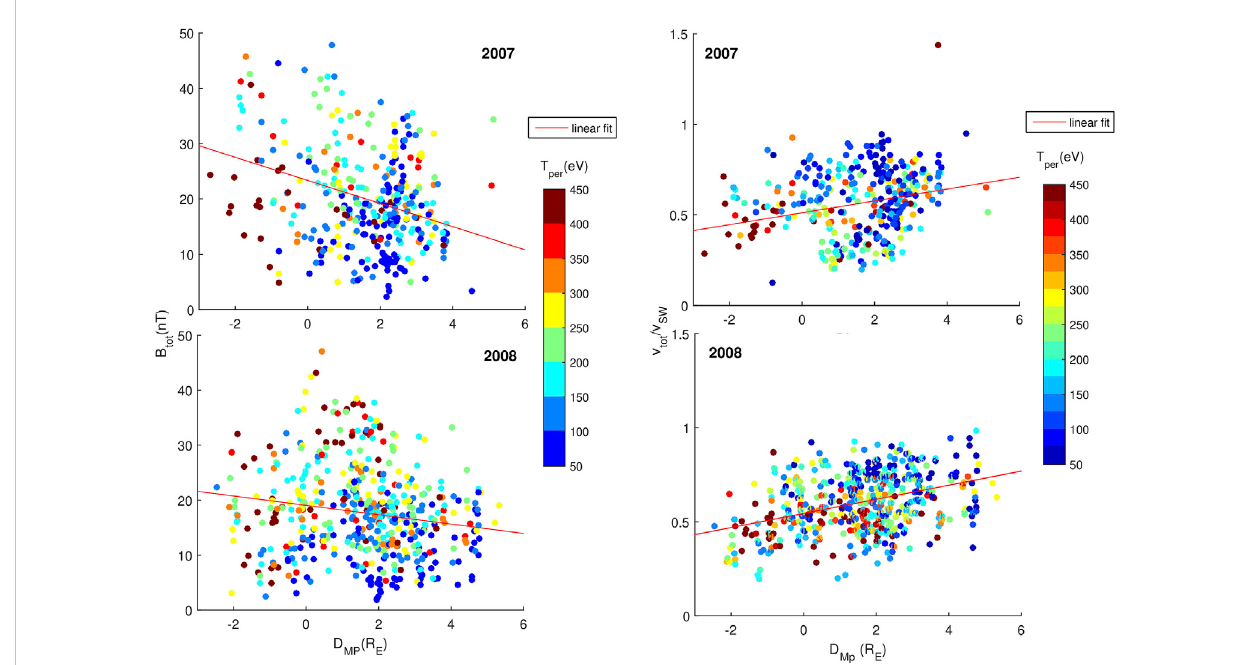
FIGURE 10 Distribution of ratio between jets speed and solar wind speed ( v tot /V SW , right column) and magnetic fi eld ( B tot , left column) as a function of the distance to the magnetopause ( DIST MP ), for 2007 (top row), and 2008 (bottom row). The symbols identify the position of each individual jet, the color assignedtoeachsymbolisameasureoftheperpendiculartemperature. Dist MP isthedistancefromthejetpositiontothemagnetopause,estimatedusing the Shue et al. (1997) model (see text for details); negative values indicate the jet is detected downstream the model magnetopause. The red lines trace a linear regression over the ensemble of data in each